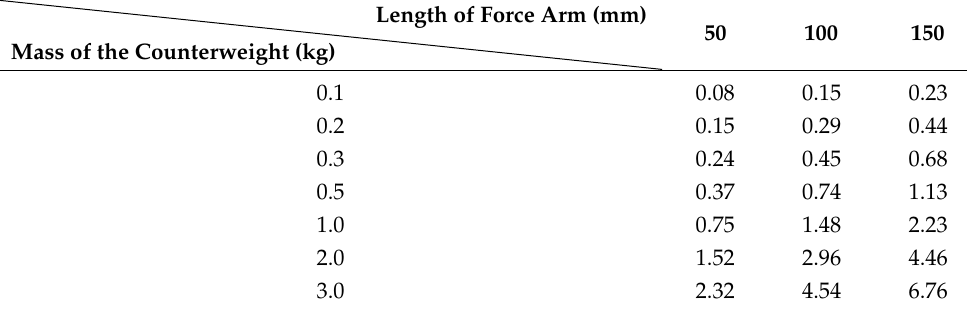
Table 3. The value of torque loading by counterweight (N · m).